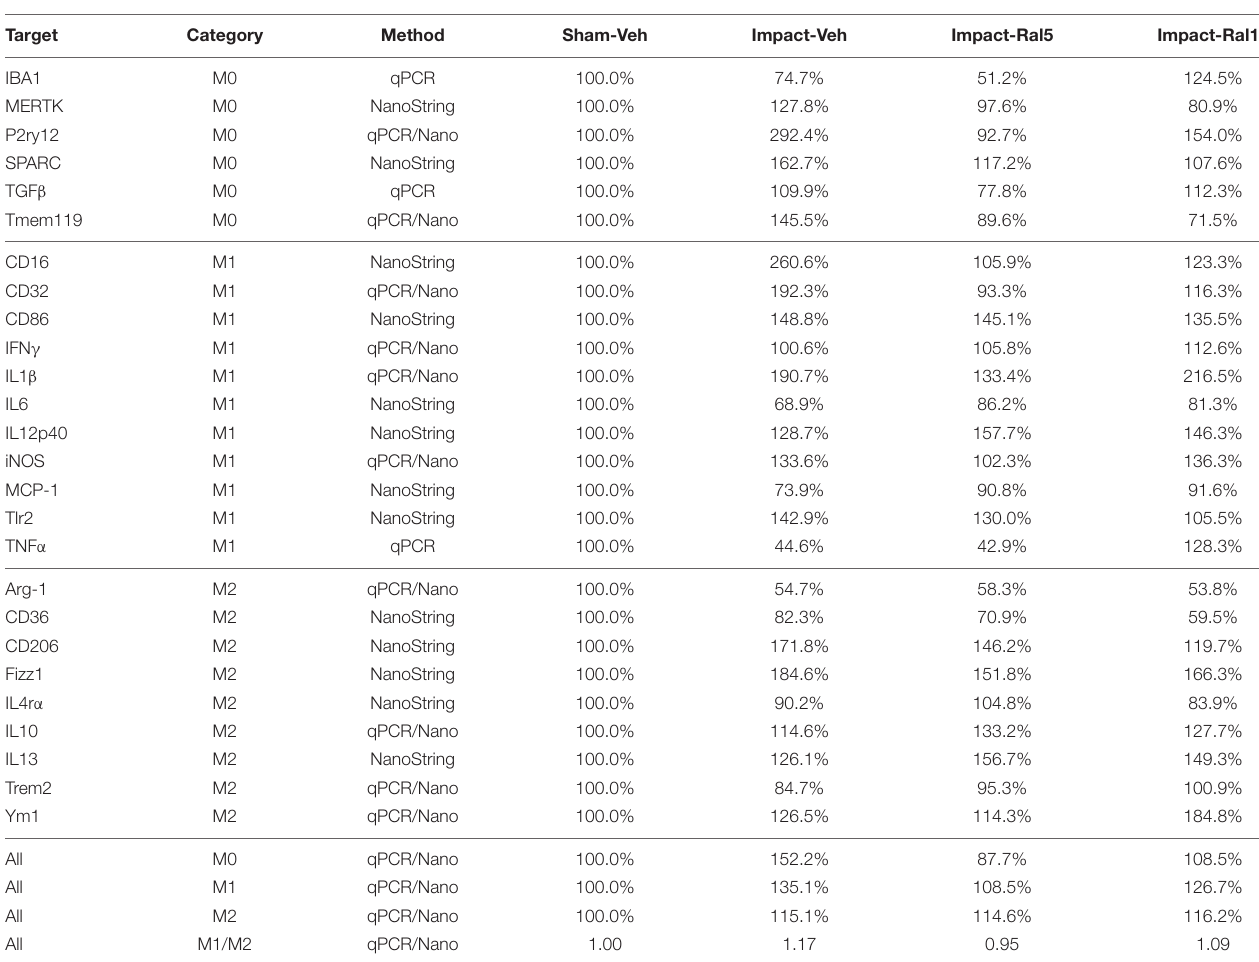
TABLE 4 | Expression of microglial transcripts in